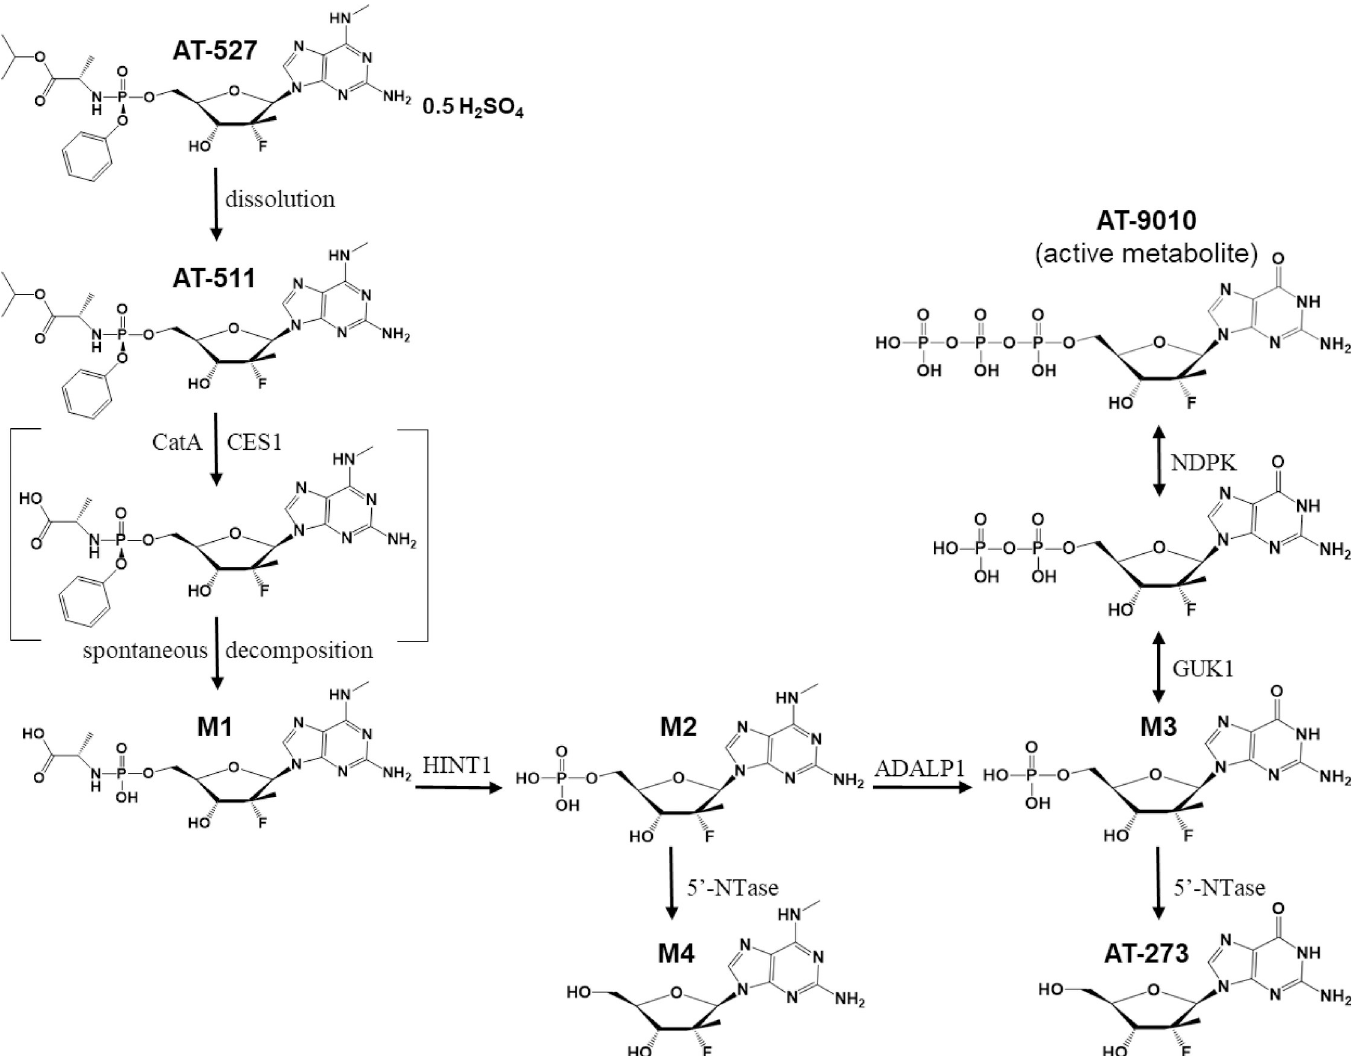
Fig 2. Putative metabolic pathway for AT-527. When dissolved, AT-527 releases its free base AT-511. Sequential hydrolysis, catalyzed by human cathepsin A (CatA) and/or carboxylesterase 1 (CES1) followed by spontaneous cleavage of the then unstable phenolic moiety, produces the L-alanyl intermediate (M1). Removal of the amino acid moiety by histidine triad nucleotide-binding protein 1 (HINT1) results in metabolite M2 which can then be converted to M3 by adenosine deaminase like protein 1 (ADALP1). M3 is further anabolized sequentially by guanylate kinase 1 (GUK1) and nucleoside diphosphate kinase (NDPK) to the pharmacologically active triphosphate, AT-9010. Both M2 and M3 can be dephosphorylated by 5’-nucleotidase (5’-NTase) to their respective nucleosides M4 and AT-273.